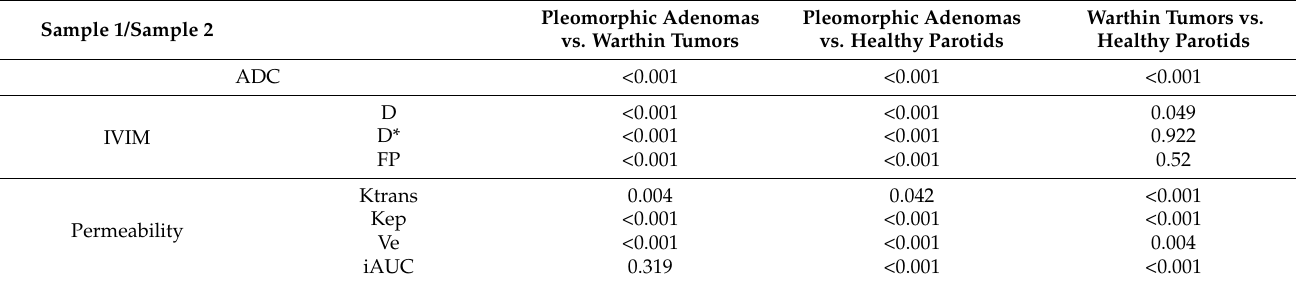
Table 5. Kruskal–Wallis test for independent samples.